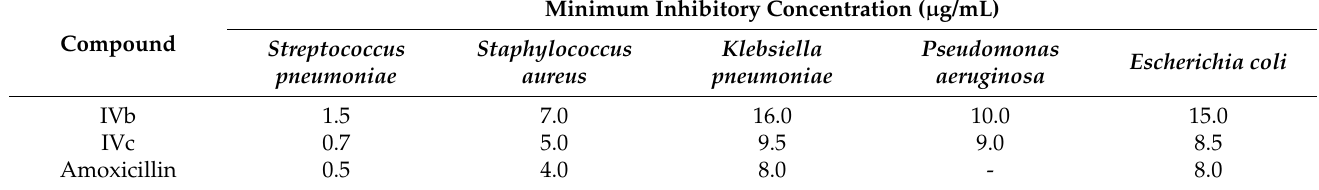
Table 7. Minimum inhibitory concentration of the penicillins IVb and IVc with amoxicillin as reference